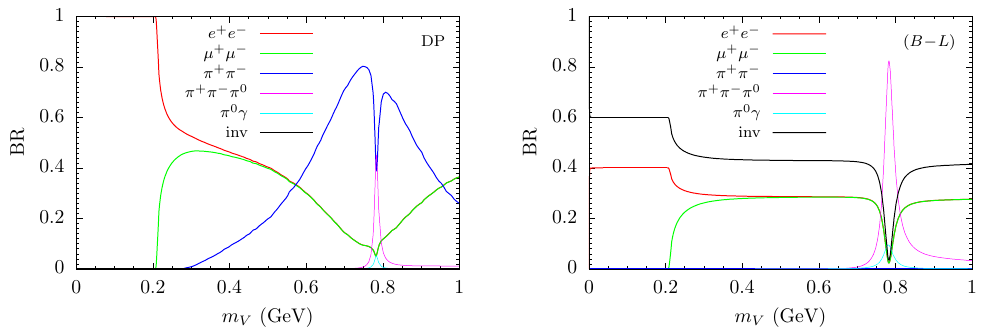
Figure 1 . Decay branching ratios (BR) as a function of the vector mass m photon (left), or B (cid:0) L (right) vector